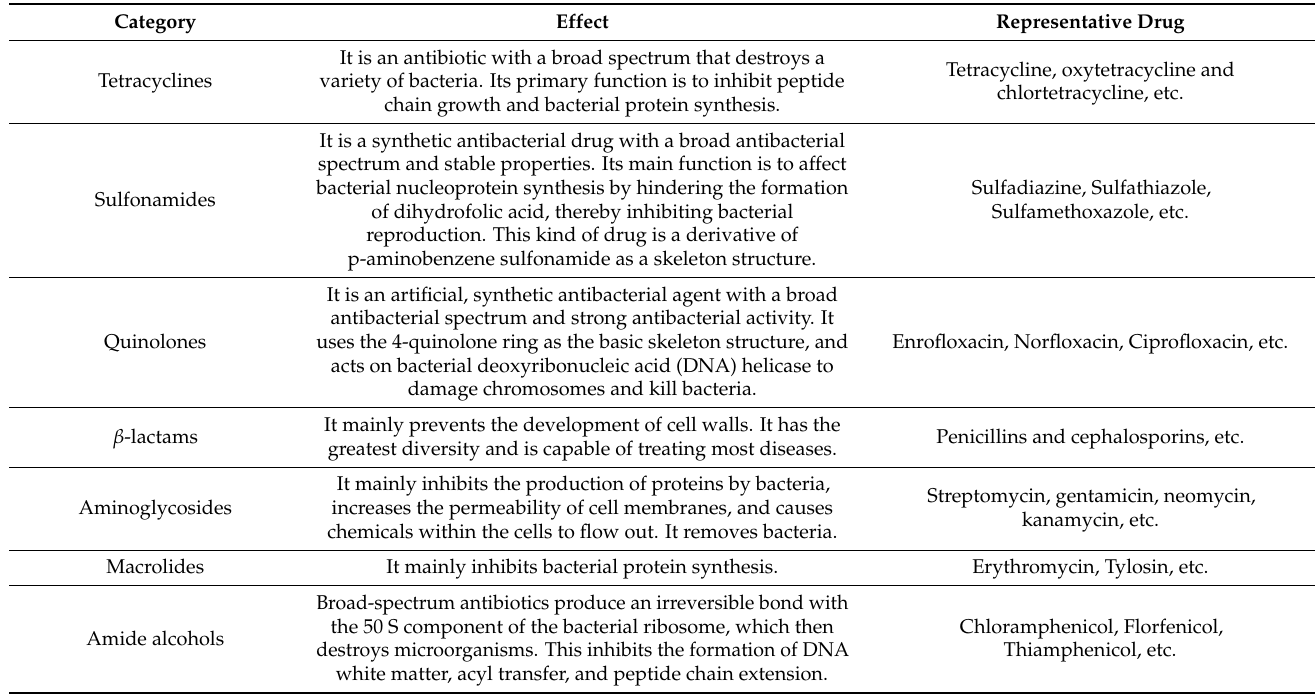
Table 2. Common types of antibiotics and representative drugs